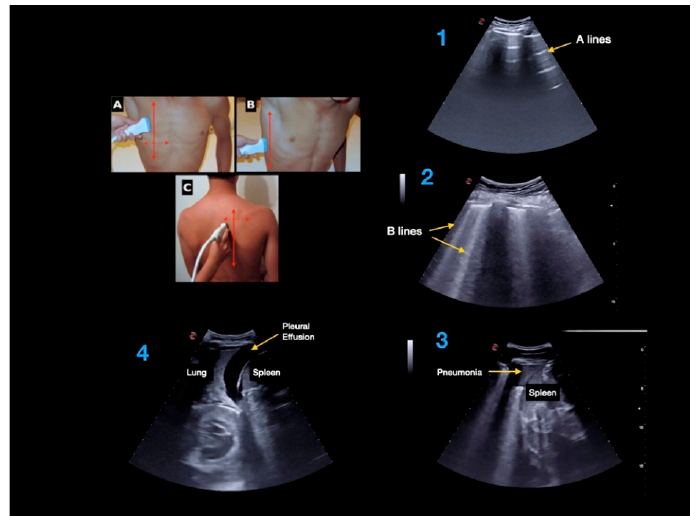
Figure 2. Lung ultrasound exam: ( A ) anterior, ( B ) lateral, and ( C ) posterior areas of both lungs. Lung ultrasound findings: (1) A-lines, (2) B-lines, (3) consolidation, and (4) pleural effusion.